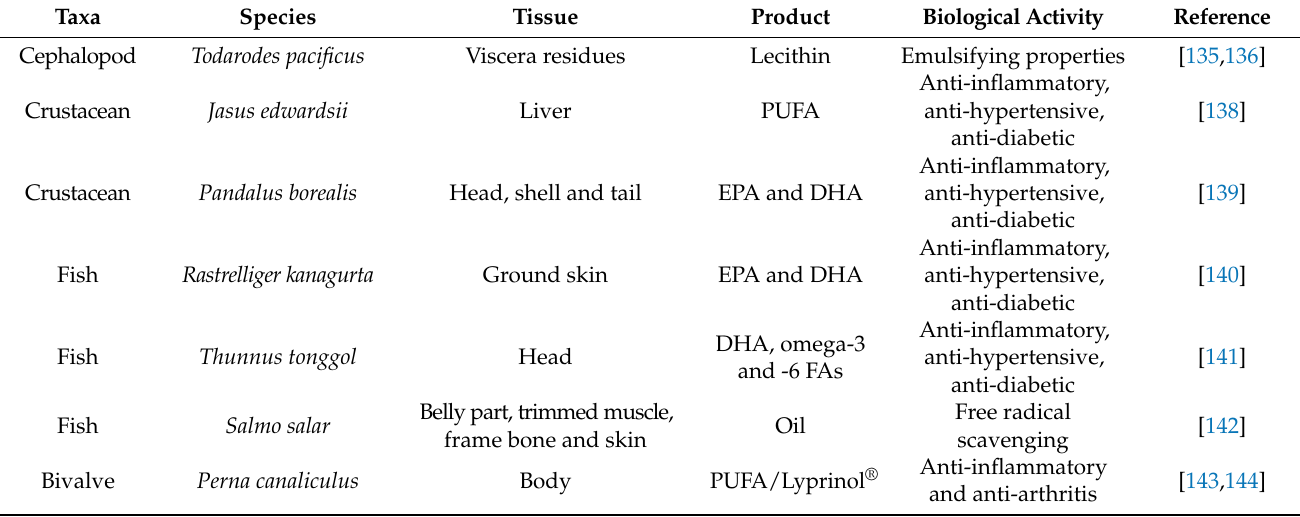
Table 4. Lipids from seafood wastes, together with taxa, species and tissue from which they were isolated, and their biotechnological